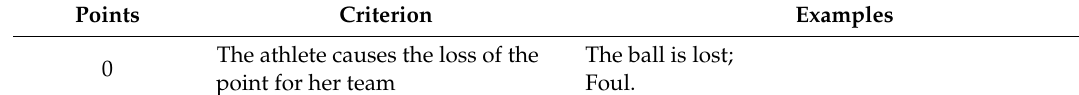
Table 1. Attribution criteria for the raw individual score